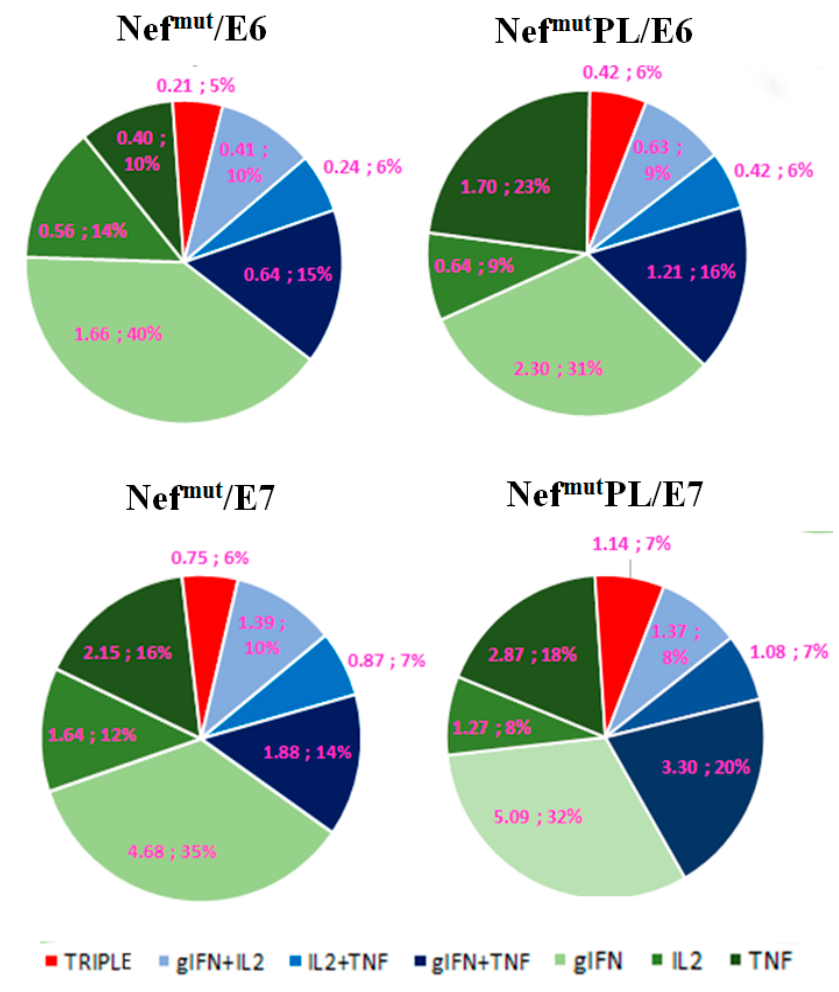
Figure 4. HPV16 E6-and E7-specific CD8 + T cell immunity induced in mice after injection of DNA vectors expressing either Nef mut or Nef mut PL. ( A ). CD8 + T cell immune response in C57 Bl/6 mice inoculated with DNA vectors expressing the indicated fusion products. As a control, mice were inoculated with vectors expressing either Nef mut or Nef mut PL. At the time of sacrifice, 2.5 × 10 5 splenocytes were incubated ON with or without 5 µg/mL of either unrelated (not shown), E6, or E7-specific peptides in triplicate IFN- γ EliSpot microwells. Shown are the number of IFN- γ SFUs/well as mean values of triplicates. Intragroup mean values +SD are also reported. ( B ). IFN- γ , IL-2, and TNF- α expression in CD8 + T cells from cultures of splenocytes isolated from each mouse injected with the indicated DNA vectors. Splenocytes were incubated ON with or without 5 µg/mL of either unrelated, E6 or E7-specific peptides in the presence of brefeldin A, and then analyzed by ICS. Shown are the mean values +SD of positive CD8 + T cells within total alive CD8 + T cells for each cytokine, as calculated after subtraction of values detected in CD8 + T cells from cultures treated with the unrelated peptide. Ctrl: mean values from cultures of splenocytes isolated from mice injected with Nef mut and Nef mut PL expressing vectors. (C). Pie charts indicating the means of both absolute (i.e., over the total of analyzed CD8 + T cells) and relative percentages of CD8 + T cells expressing cytokine combinations within pools of splenocytes from mice injected with the indicated vectors. Percentages were calculated after subtraction of values detected in homologous cultures treated with unrelated peptides. Values detected with splenocytes from mice injected with control vectors were below the sensitivity threshold of the assay (not shown). The results are representative of two independent experiments. We concluded that the anti-HPV16-E6 and -E7 immunogenicity remained largely unchanged when the anchoring protein was deleted of 29 C-terminal amino acids.